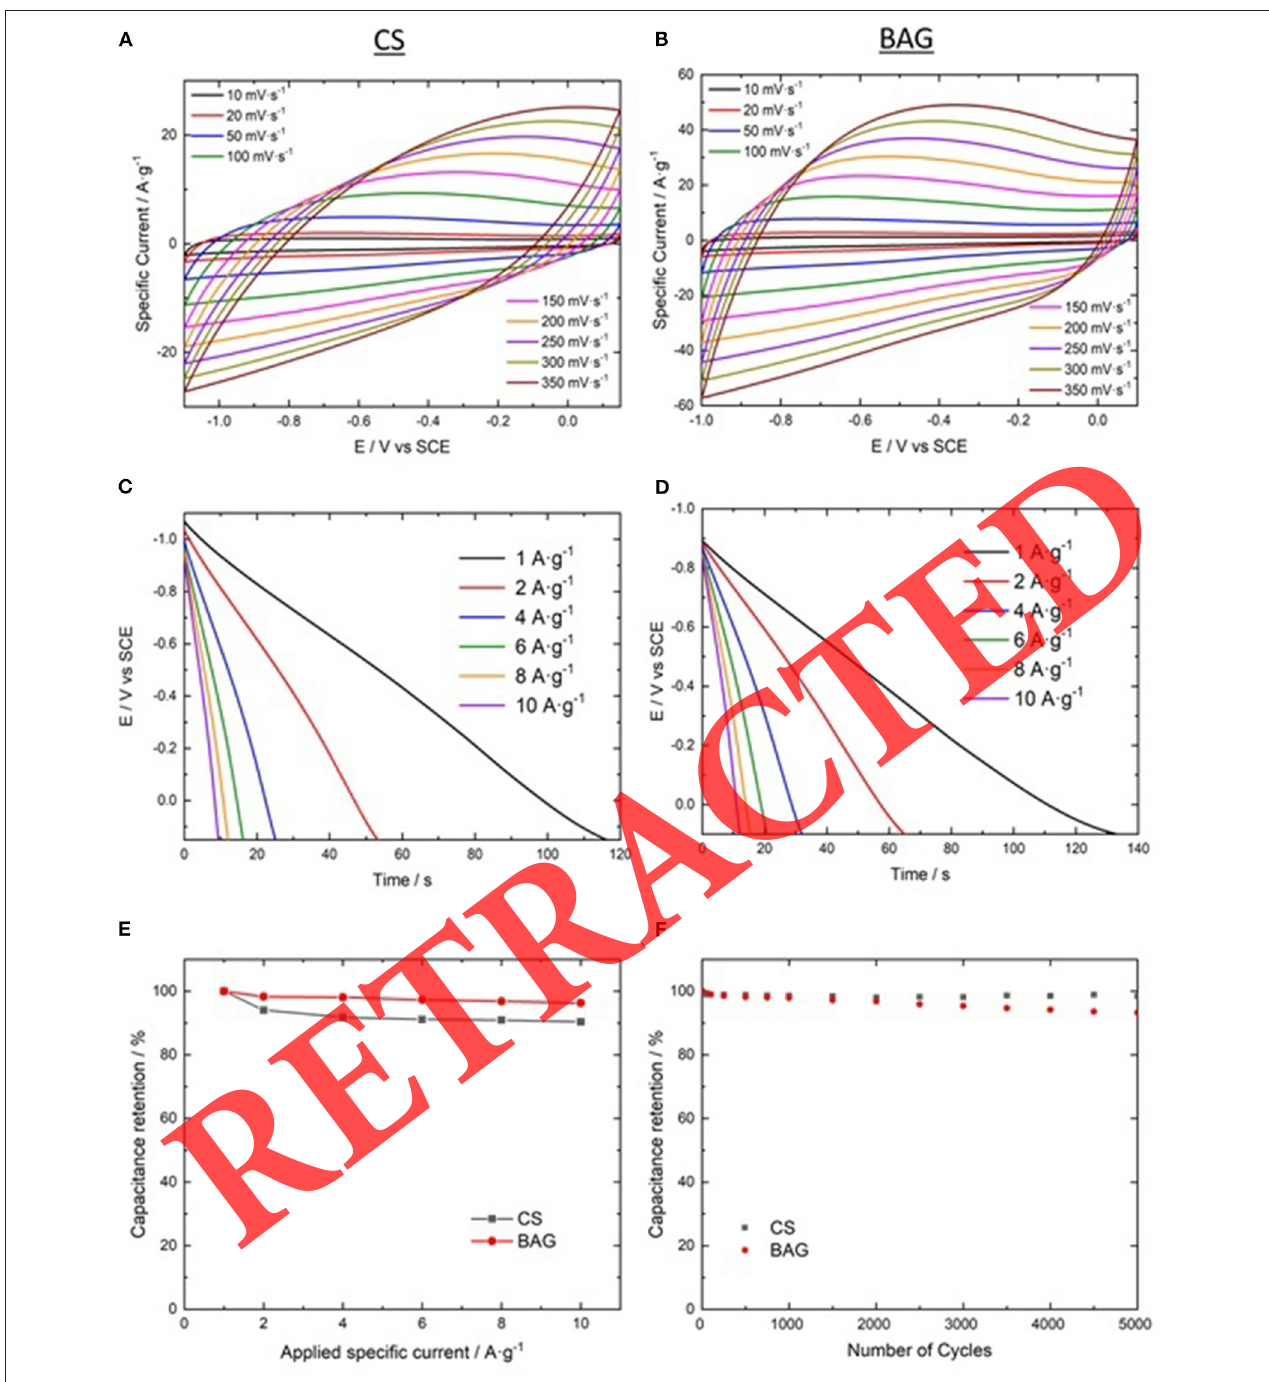
FIGURE 5 | Electrochemical characterization of CS (A,C) and BAG (B,D) by cyclic voltammetry (A,B) and galvanostatic charge–discharge (C,D) at different scan rates and applied currents, respectively. (E) Capacitance retention of each material at different applied specific currents. (F) Capacitance retention after 5,000 cycles of continuous charge–discharge at 10 A · g − 1 in 1M KOH.